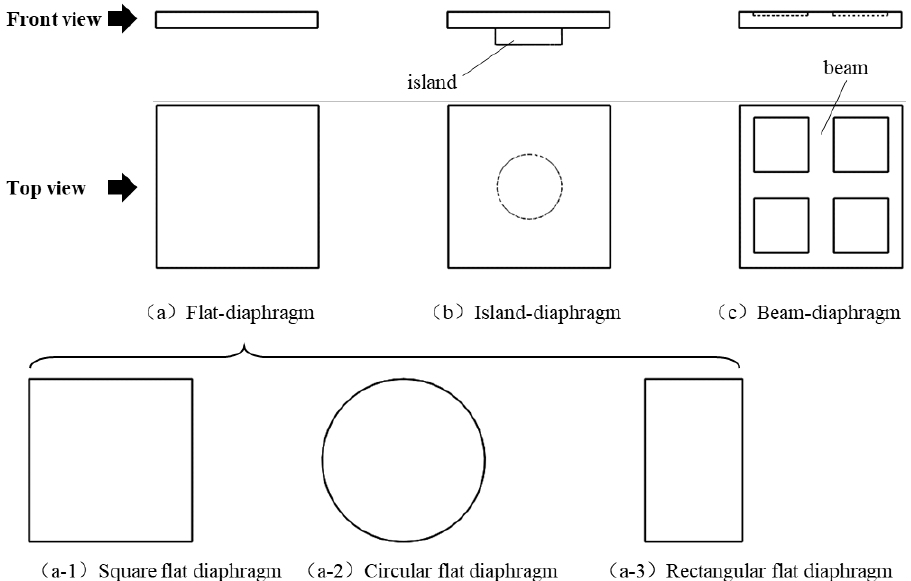
Figure 1. Common structures of pressure sensor’s sensitive diaphragm.